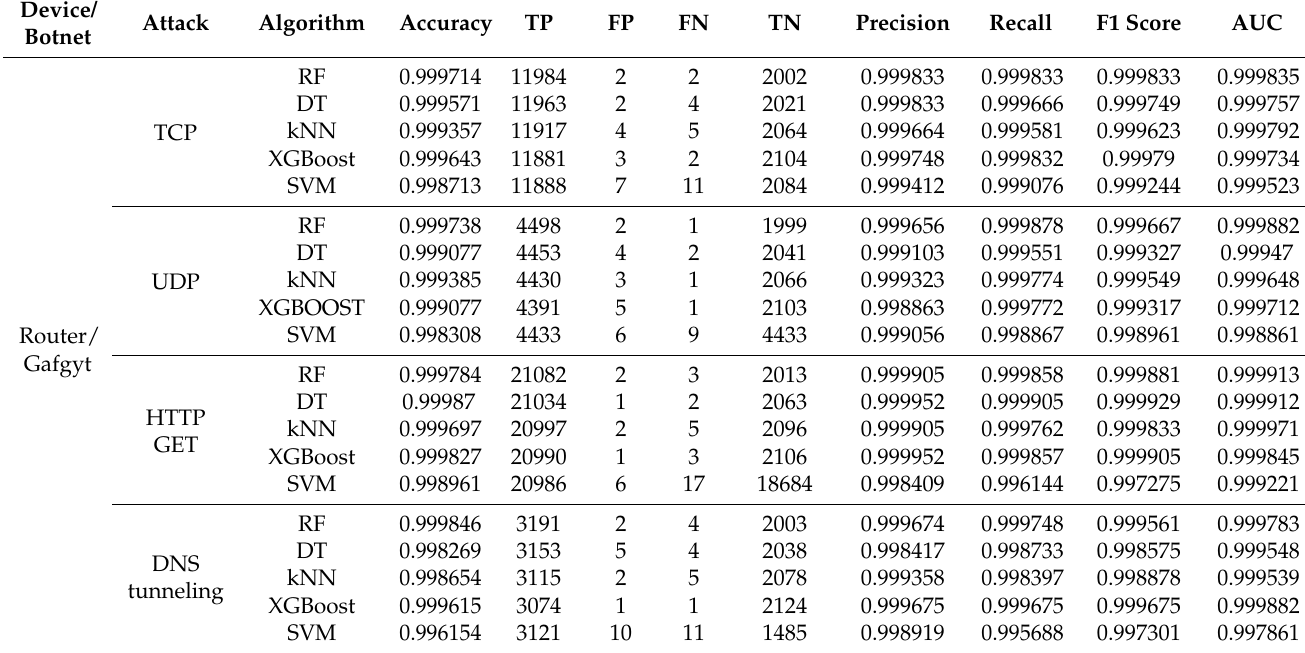
Table 12. Classification results (router—Gafgyt).